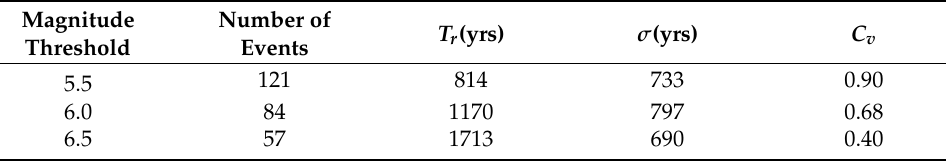
Table 2. Results of the statistical analysis of the simulated 100,000 yrs earthquake catalogue for the DISS composite source labelled ITCS106 for three different magnitudes thresholds. T r = recurrence time, σ = standard deviation, C v = coefficient of variation.